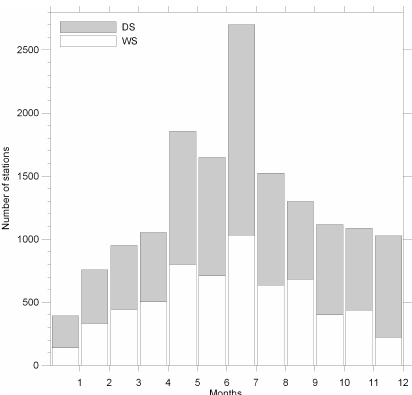
Fig. 2. The bar-chart showing distribution of the number of SST observations over 20th century. Only quality controlled data are included in this histogram and all following figures. Total height of the bars represent the total number of sampling points, open parts represent measurements taken on the shelf. There were no recorded measurements between 1900 and 1910 and during the war-time.